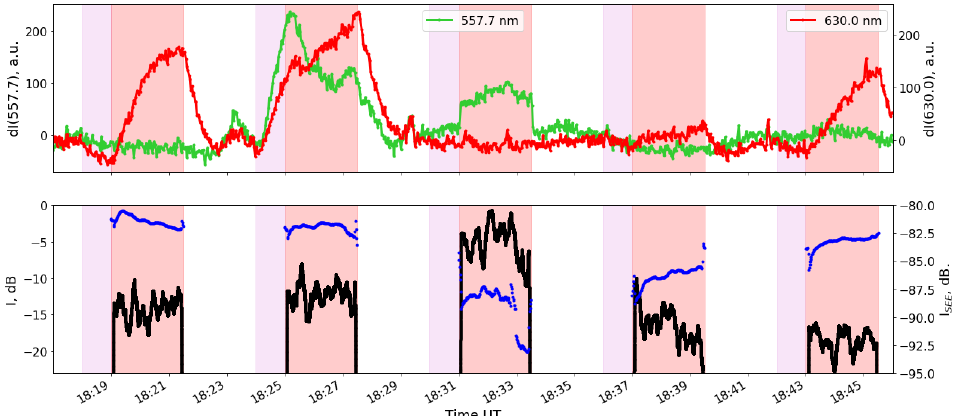
Figure 4. Upper panel : a fragment of data presented in Figure 3. Variations in the emissions intensity at 557.7nm and 630.0 nm ( upper panel ) from the photometer data (integration time 1s). Lower panel : the ionospherically reflected PW signal (black) and SEE intensity averaged over the frequency range 6.2 ≤ f SEE − f 0 ≤ 6.8 kHz